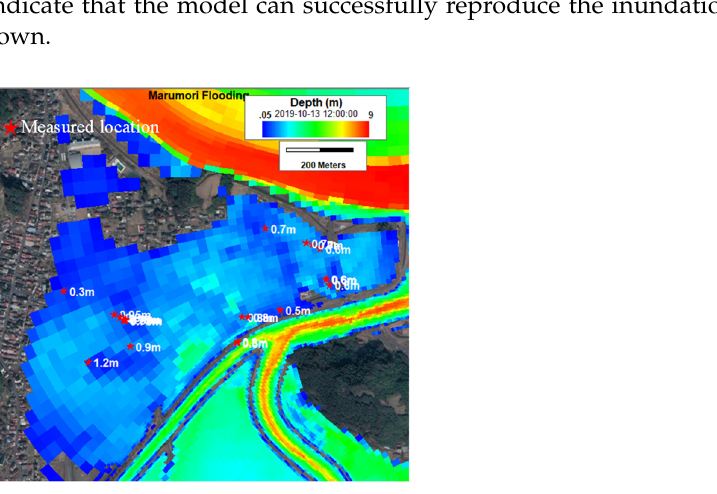
Figure 8. Model inundation map and flood marks’ survey points at Marumori Town.